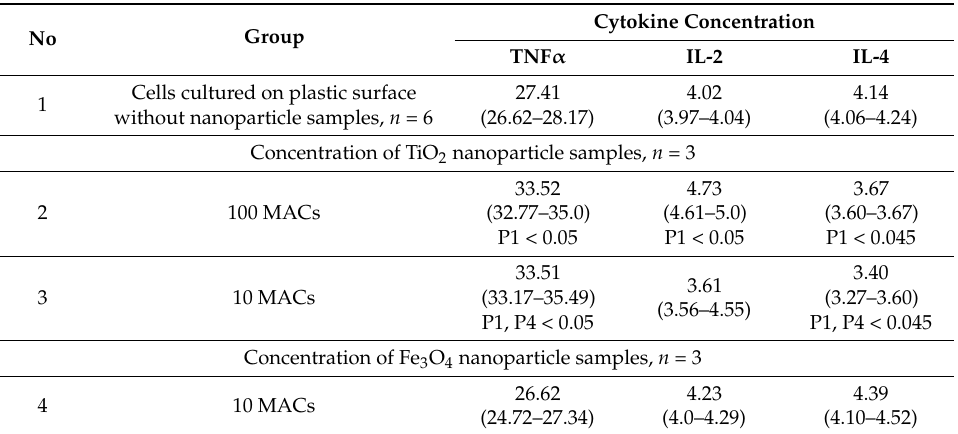
Table 8. Cytokine levels (pg/mL) in the culture medium after 24 h of culture of Jurkat T cells with nanoparticle suspensions, Me (Q 1 –Q 3